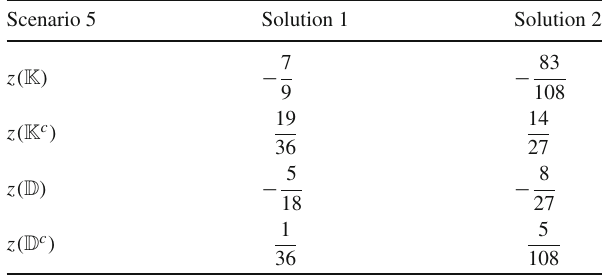
Table 26 The same as in Table 25, but for the hypercharges of Case 2 of Table 10